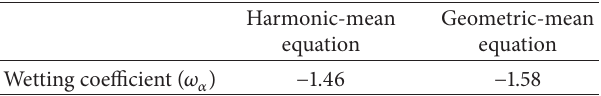
Table 4: The wetting coefficient values calculated by different equations. Wetting coefficient ( 𝜔 𝛼 ) −